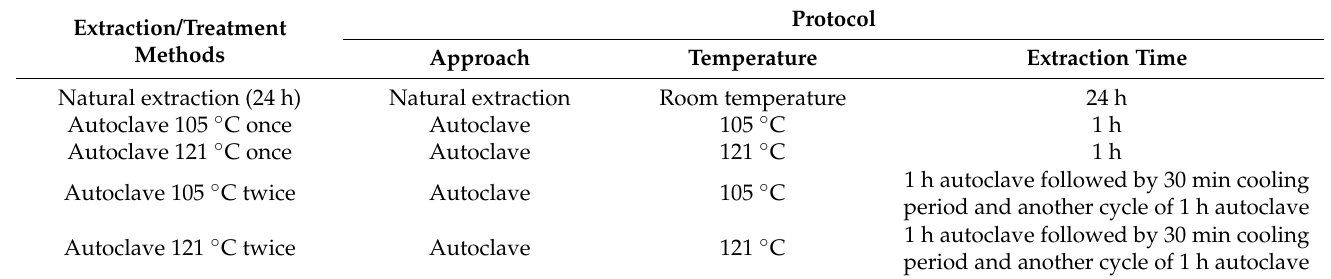
Table 2. Utilization of five different extraction methods for the preparation of soil